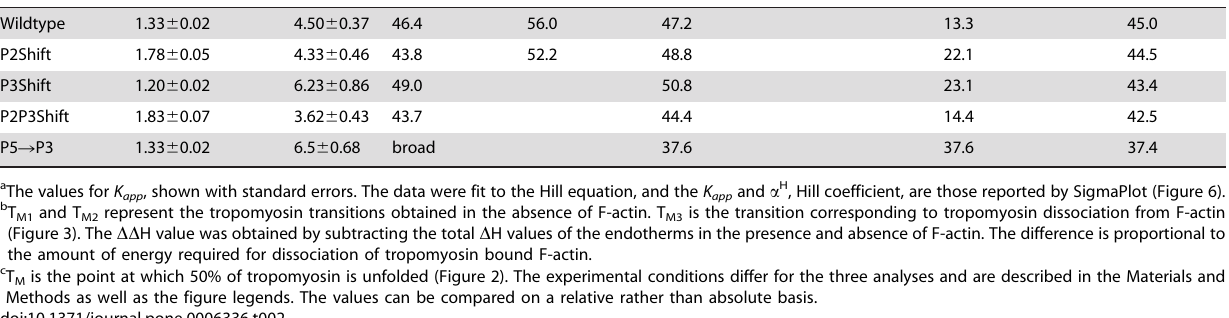
Tropomyosin K app ( 6 10 6 M 2 1 ) a a H